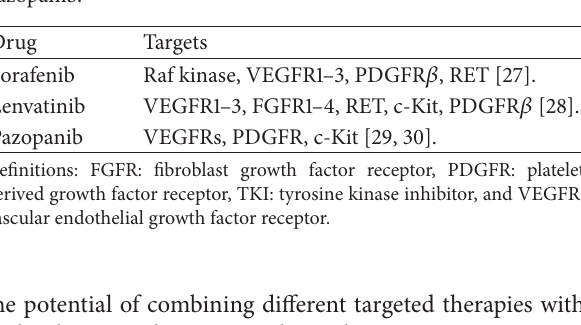
Table 5: Molecular targets of the TKIs sorafenib, lenvatinib,